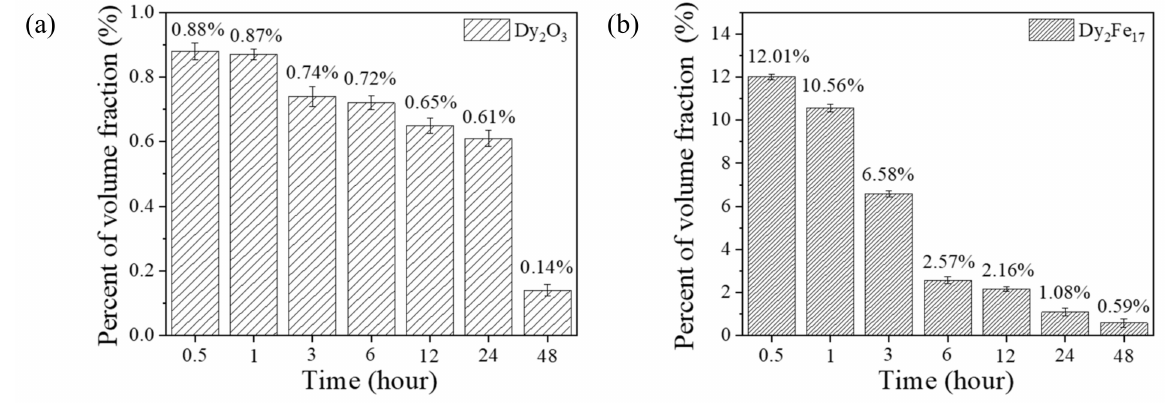
Figure 6. The volume fraction of remained phase with reaction time ( a ) Dy 2 O 3 ( b ) Dy 2 Fe 17